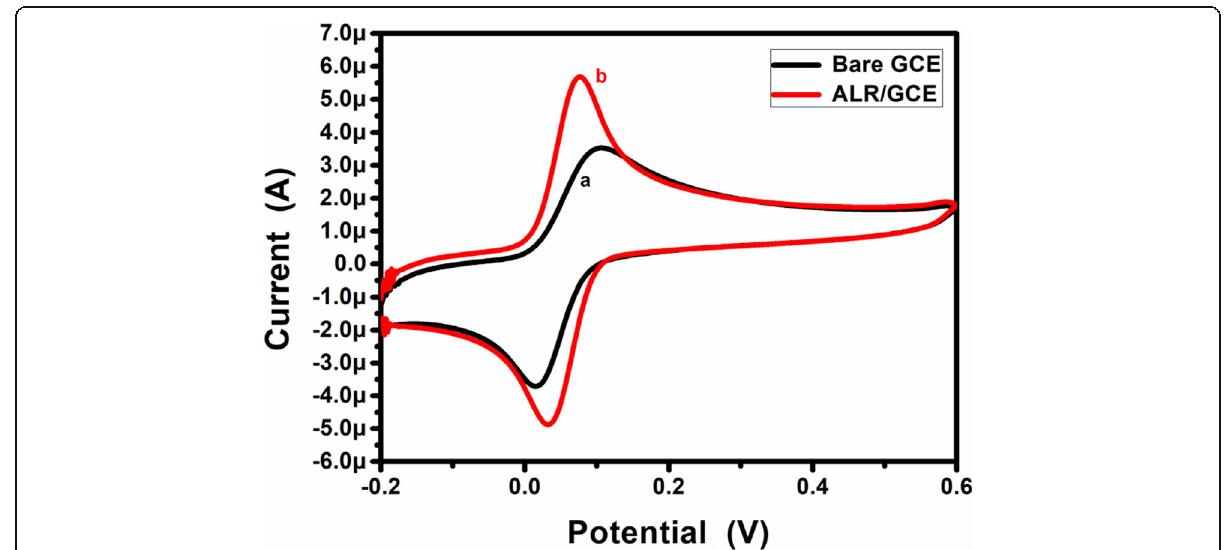
Fig. 2 CVs of 40.0 μ M HQ at bare GCE (curve a) and ALR/GCE (curve b) in 0.2 M buffer of pH 7.4 with 0.05 Vs − 1 scan rate